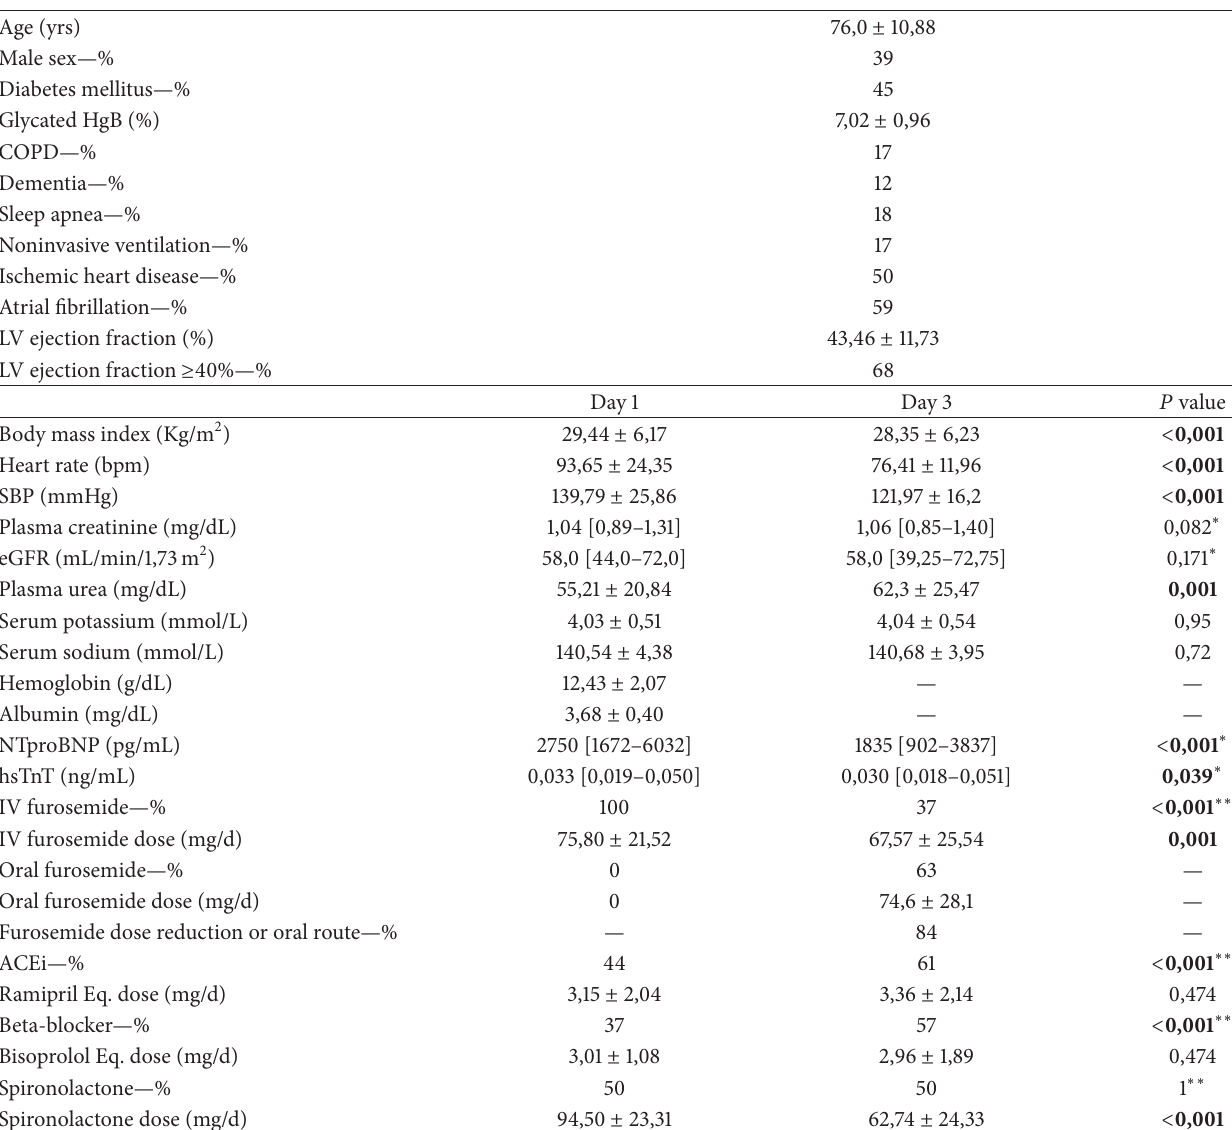
Table 1: Population characteristics and comparison of clinical variables, laboratory results, and medications between admission day (day 1) and day